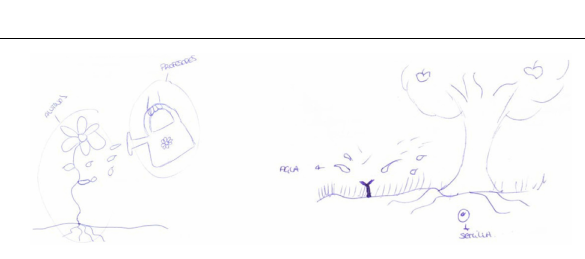
Frontiers in Psychology |